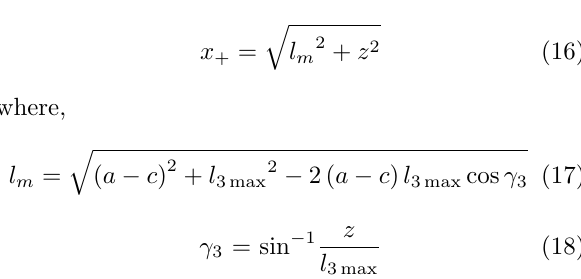
The maximum displacement of the MP along the positive x axis for a given z is expressed as follows: